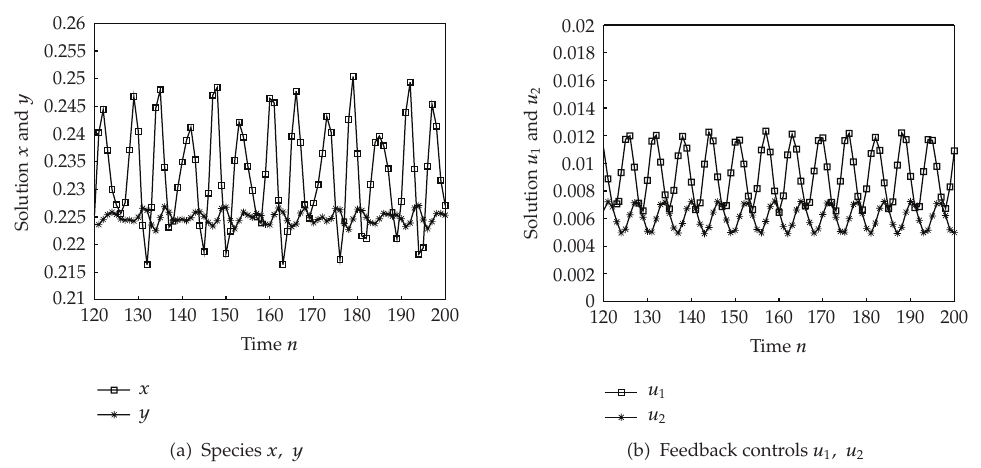
Figure 1: Dynamics behaviors of system (cid:6) 5.1 (cid:7) with initial conditions (cid:6) x (cid:6) 0 (cid:7) ,y (cid:6) 0 (cid:7) ,u 1 (cid:6) 0 (cid:7) ,u 2 (cid:6) 0 (cid:7)(cid:7) T (cid:8) (cid:6) 0 . 31 , 0 . 26 , 0 . 02 , 0 . 08 (cid:7) T and (cid:6) 0 . 18 , 0 . 18 , 0 . 01 , 0 . 1 (cid:7) T ,